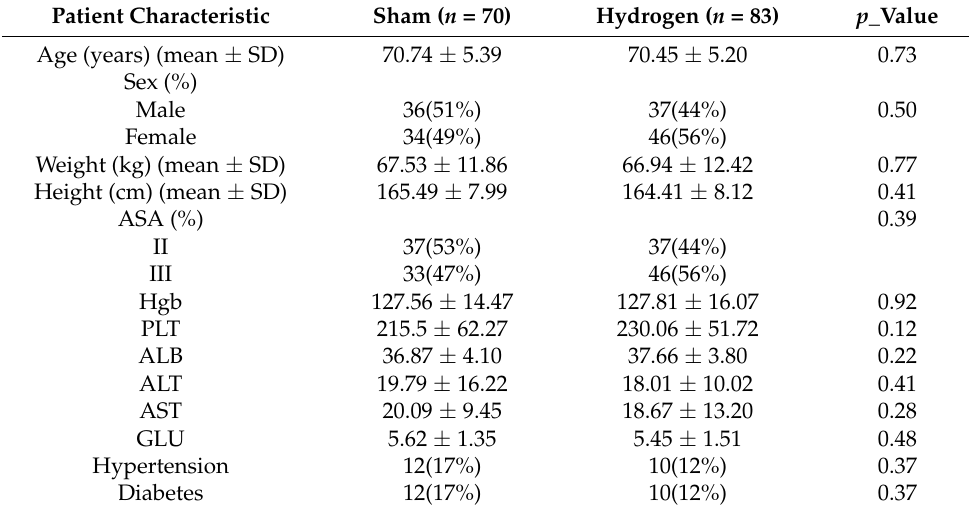
Table 1. Patient characteristics.